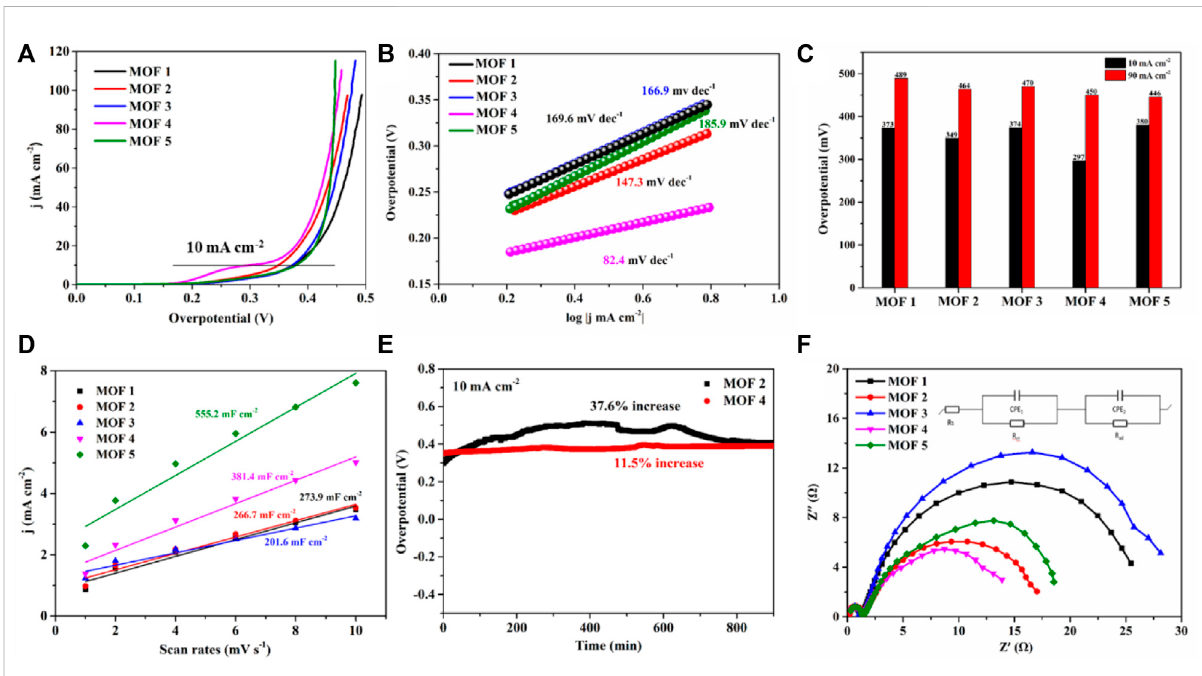
FIGURE 6 (A) LSVcurves; (B) Tafelplots; (C) summaryofoverpotentials(at10and90 mA cm − 2 ); (D) double-layercapacitance(C dl )plotsforYMUN1 – 5; (E) stabilities of two and four for the OER; (F) Nyquist plots for 1 – 5 in a 1.0 M KOH solution.